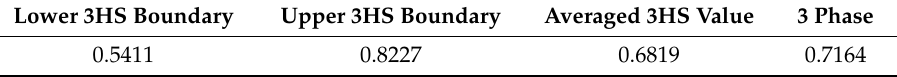
Table 10. Three-phase thermal conductivity approximations—cement system B. Lower 3HS Boundary Upper 3HS Boundary Averaged 3HS Value 3 Phase 0.5411 0.8227 0.6819 0.7164